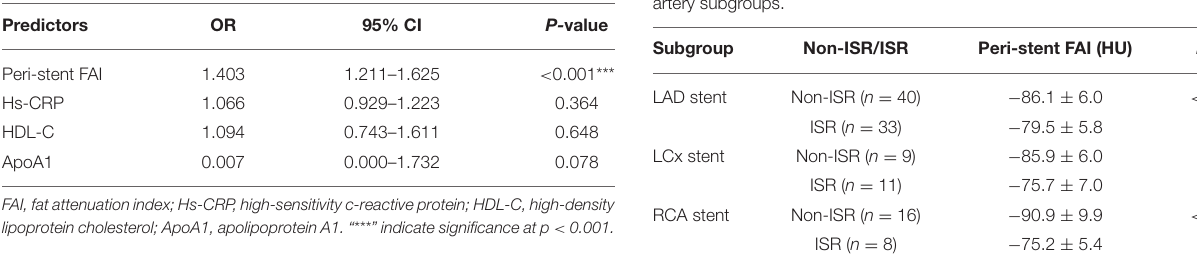
TABLE 4 | Binary logistic regression analysis for predictors of stent ISR.